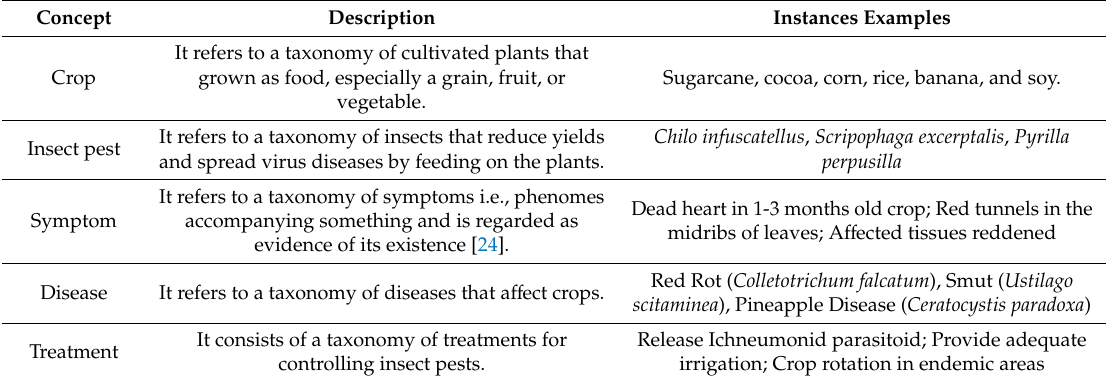
Table 2. Classes defined by the AgriEnt-Ontology.